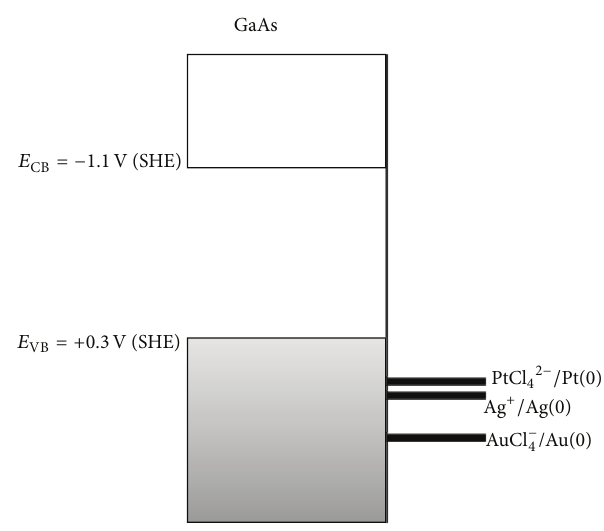
Figure 9: Schematic diagram of interfacial energetics of GaAs and relevant metal